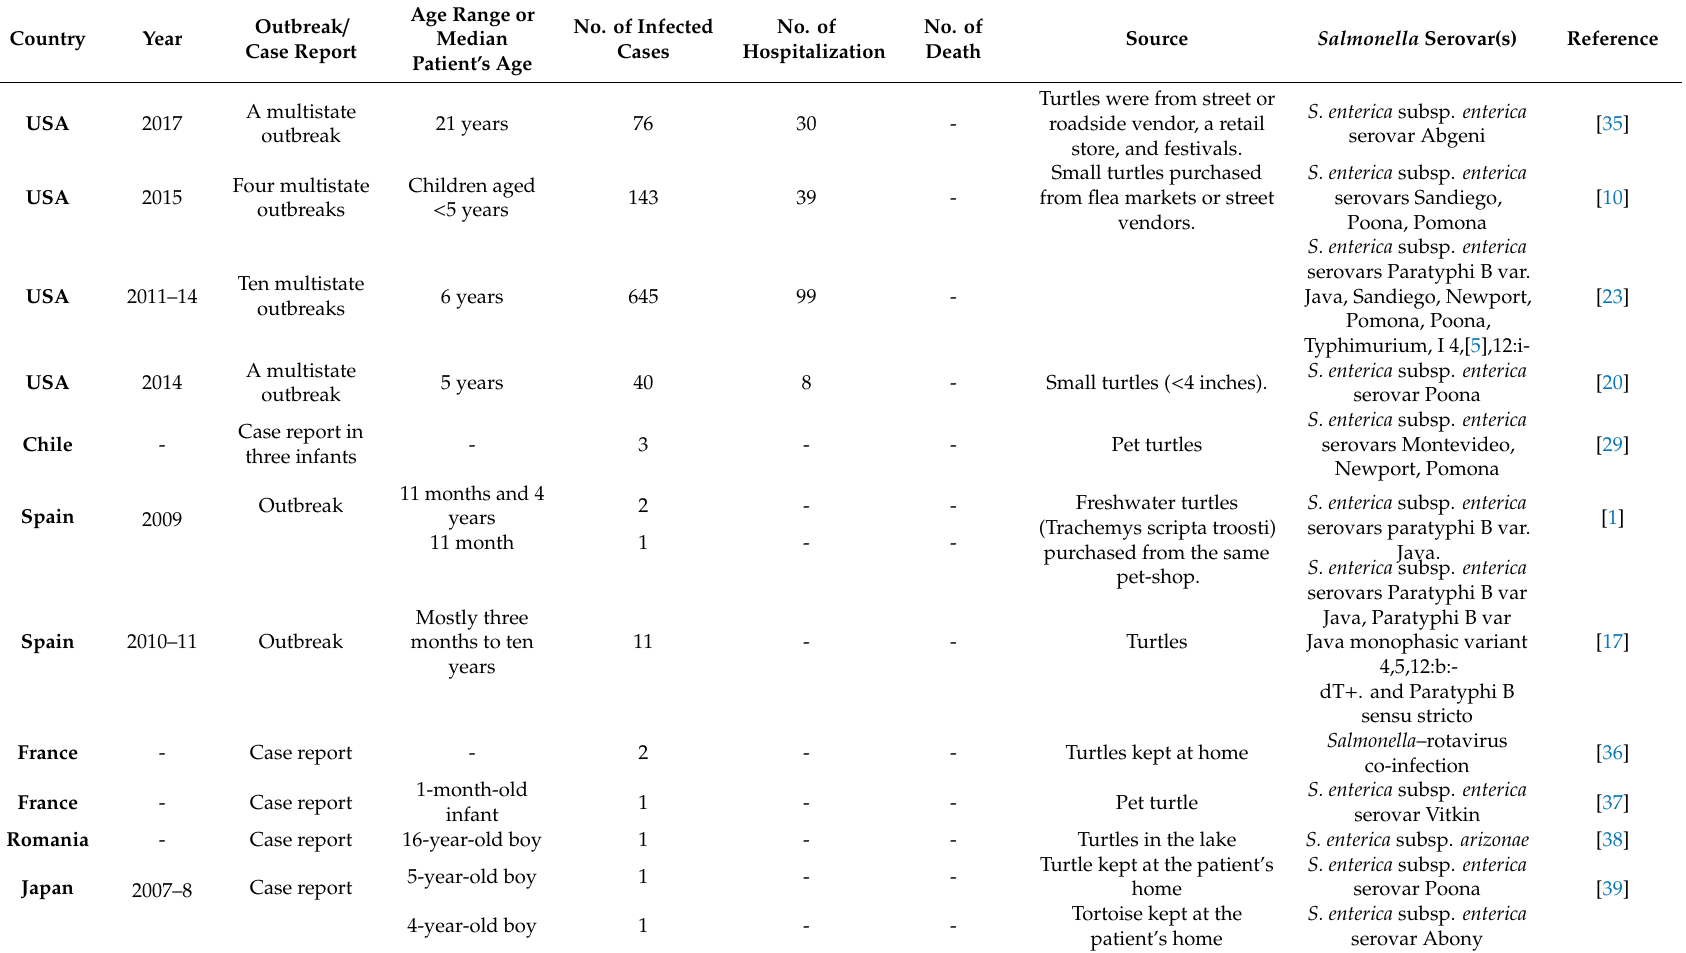
Table 2. Turtle-associated human salmonellosis in di ff erent countries in the last ten